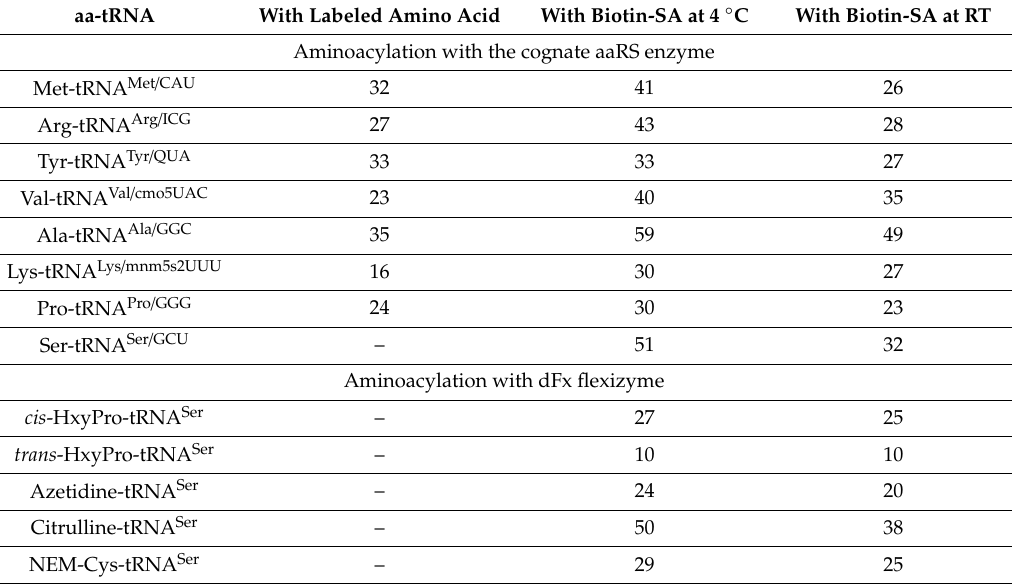
Table 1. Quantification of aminoacylation of tRNA